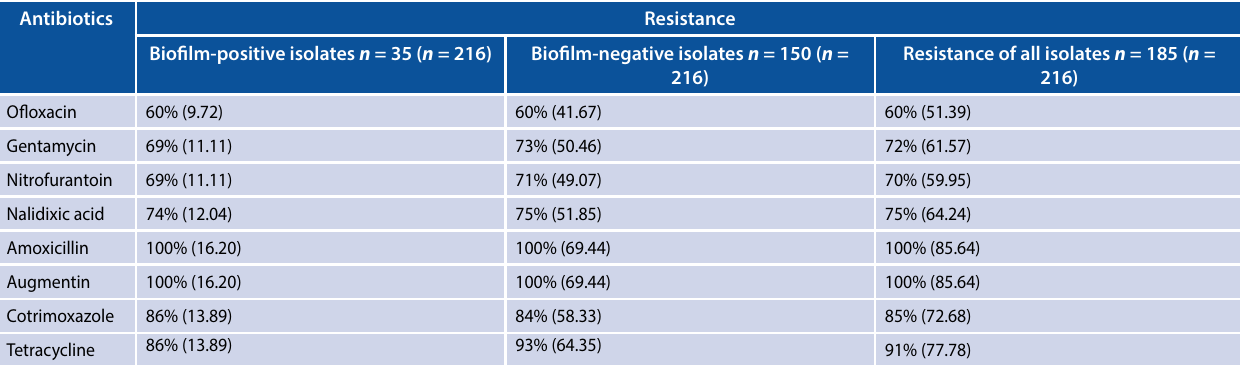
Table 5: Antibiotic resistance rate of gram-positive biofilm and non-biofilm producers